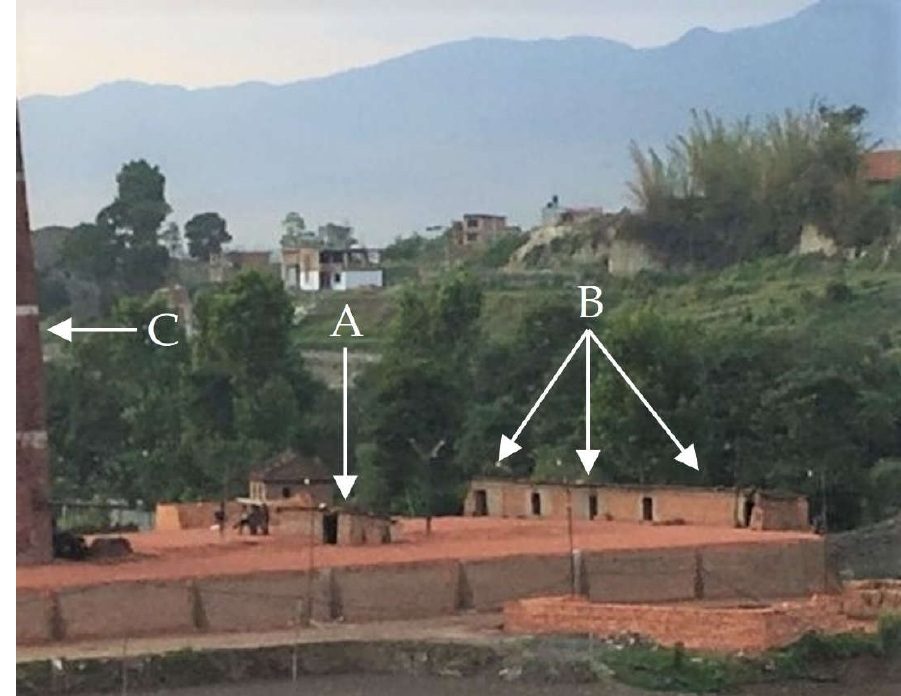
Figure 1. (A) Home of fire master on the brick kiln (for fixed chimney Bull’s trench brick kilns), (B) homes of brick workers adjacent to the brick kiln, and (C) brick kiln chimney in Bhaktapur, Kathmandu Valley, Nepal, May 2018.